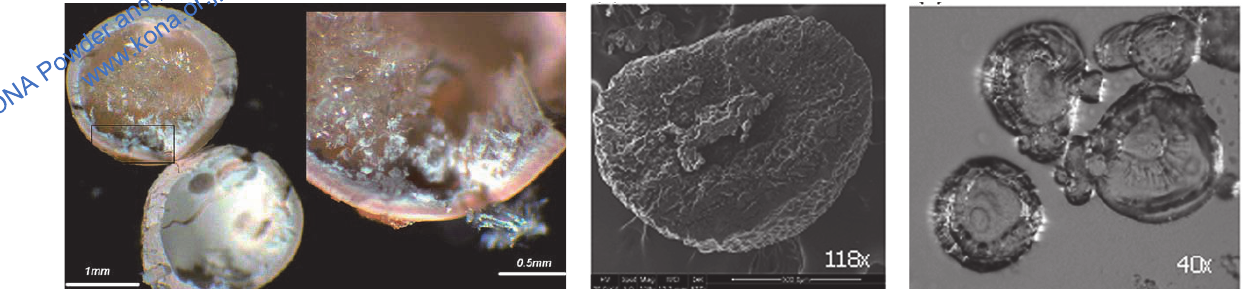
Fig. 7 Cross-section of hollow core-shell beads synthesized from MCE and EGCG solutions (left) 107) and chitosan beads with vitamin A palmitate embedded in the core matrix and surrounded by double chitosan-alginate and calcium- alginate shells 104)